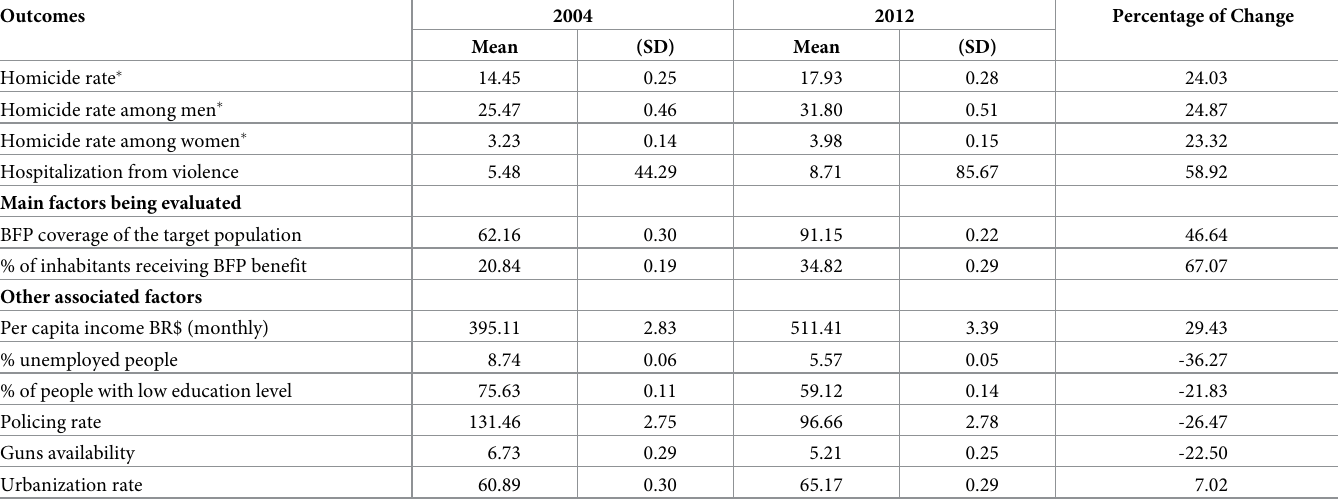
Table 1. Mean values and SD of selected variables for the Brazilian municipalities (n.